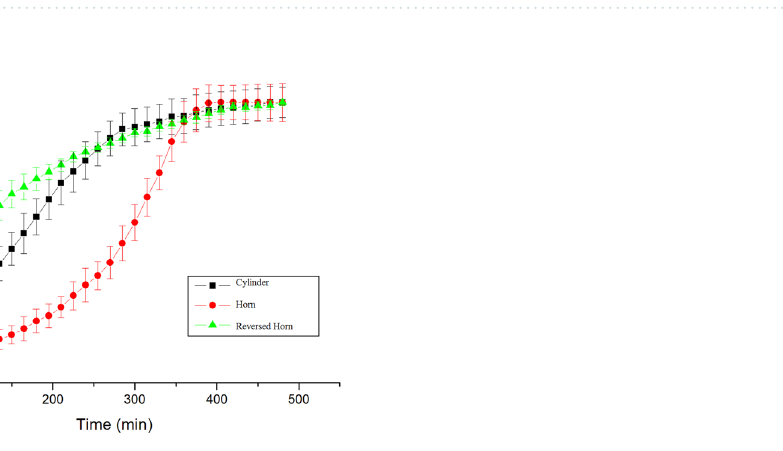
Figure 4. SEM visualization of cross-section of 3D printed PVA tablet with Cylinder model after injection of APAP gel. ( a ) Green part is the APAP gel, red part means PVA. ( b ) the layered structure of the shell, ( c ) The yellow part represents the perimeter of the drug.